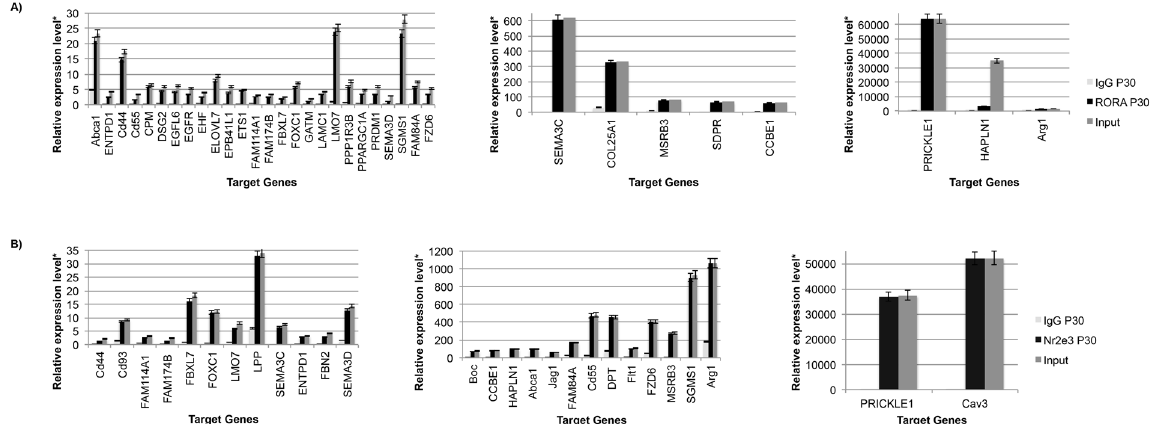
Figure 6. Chromatin IP (chIP) quantitative real time PCR (chIP-qRT-PCR) of gene targets for RORA and NR2E3 at P30. Input (positive control), RORA-chIP, NR2E3-chIP, and immunoglobulin G (IgG) negative control. * Relative expression is calculated as molecules/1000 molecules β -actin. Standard errors are indicated for each gene. All genes had a minimum significance of p < 0.05.